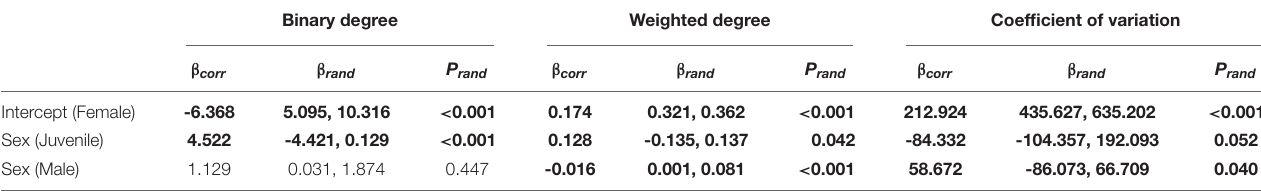
TABLE 1 | Summary of our linear models testing for the effects of demographic classes (adult female, adult male, or juvenile) on social network metrics (see Supplementary Materials section 1.3.2 for details). Binary degree Weighted degree Coefficient of variation β corr β β corr β rand P rand